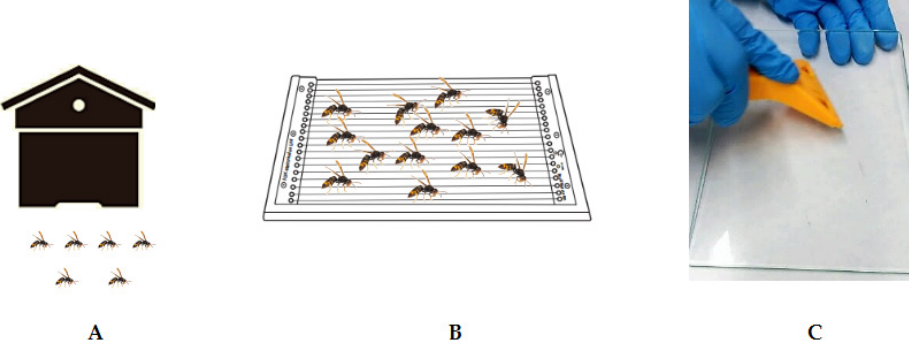
Figure 1. Sequential steps for obtaining Vespa velutina venom, based on an electric stimulation protocol: ( A ) Collection of Vespa velutina specimens in the apiary; ( B ) Vespa velutina electric stimulation; and ( C ) scraping of the Vespa velutina venom.